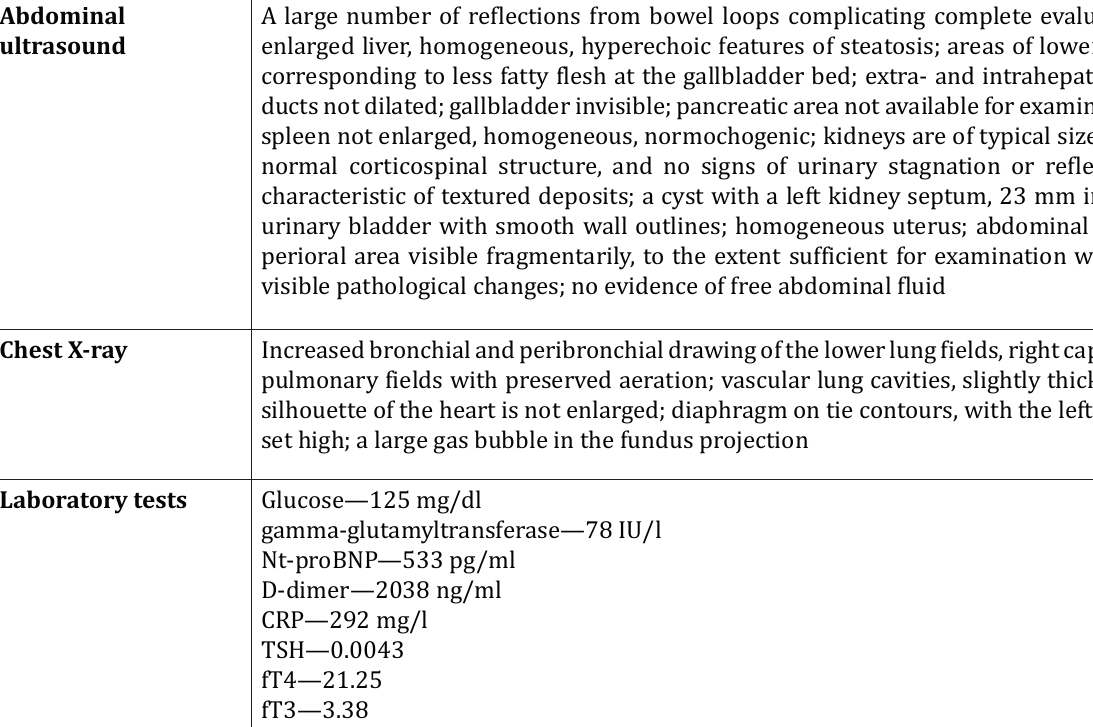
Table 1. Results of imaging and laboratory tests of the Abdominal ultrasound